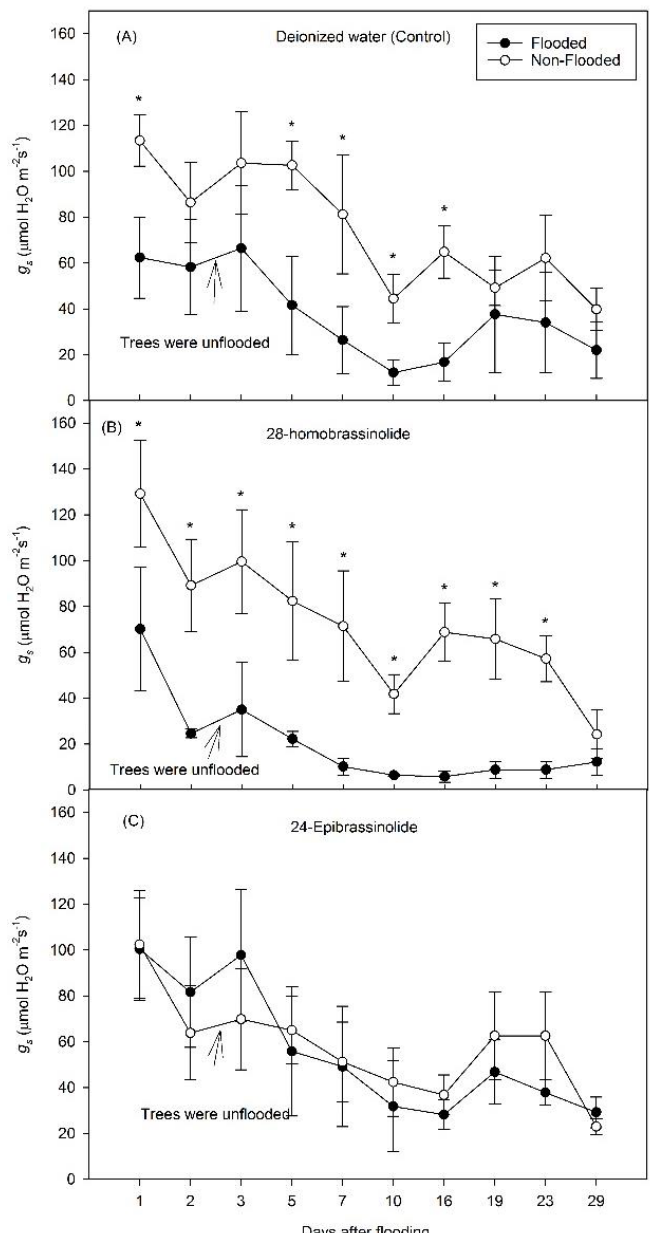
Figure 2. Effect of flooding on stomatal conductance ( g s ) of ‘Monroe’ avocado trees treated with or ( A ) deionized water as a control, ( B ) 28-homobrassinolide, or ( C ) 24-epibrassinolide (Experiment 1). Symbols and bars indicate means ± std. err. Significant differences ( p ≤ 0.05) between flooding treatments are indicated with an asterisk and were determined by repeated-measures ANOVA. ‘Trees were unflooded’ indicates the day on which trees were removed from the flooding treatment to start the recovery period.